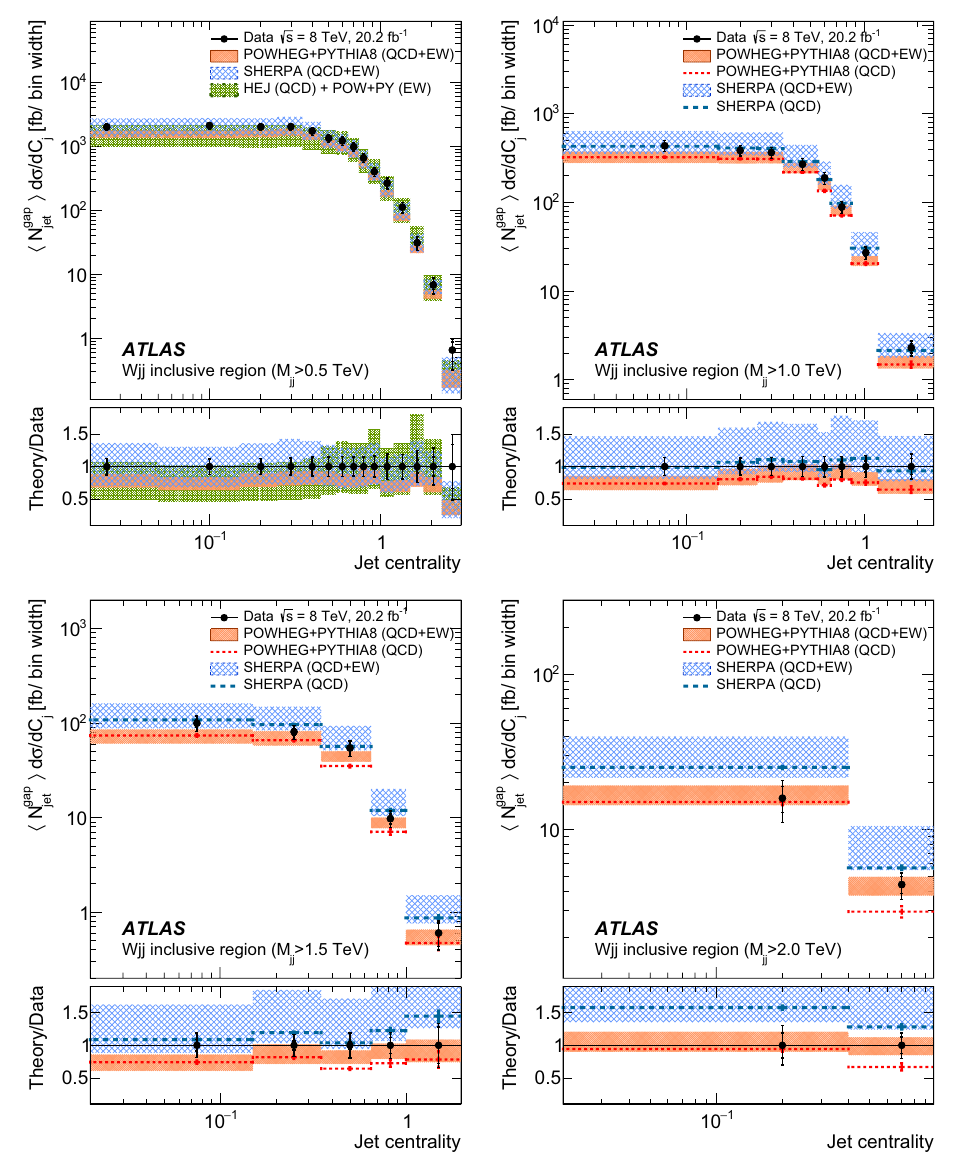
Fig. 37 Differential W jj production cross sections as a function of jet centrality in the inclusive fiducial region with four thresholds on the dijet invariant mass (0.5, 1.0, 1.5, and 2.0 TeV). Both statistical ( inner